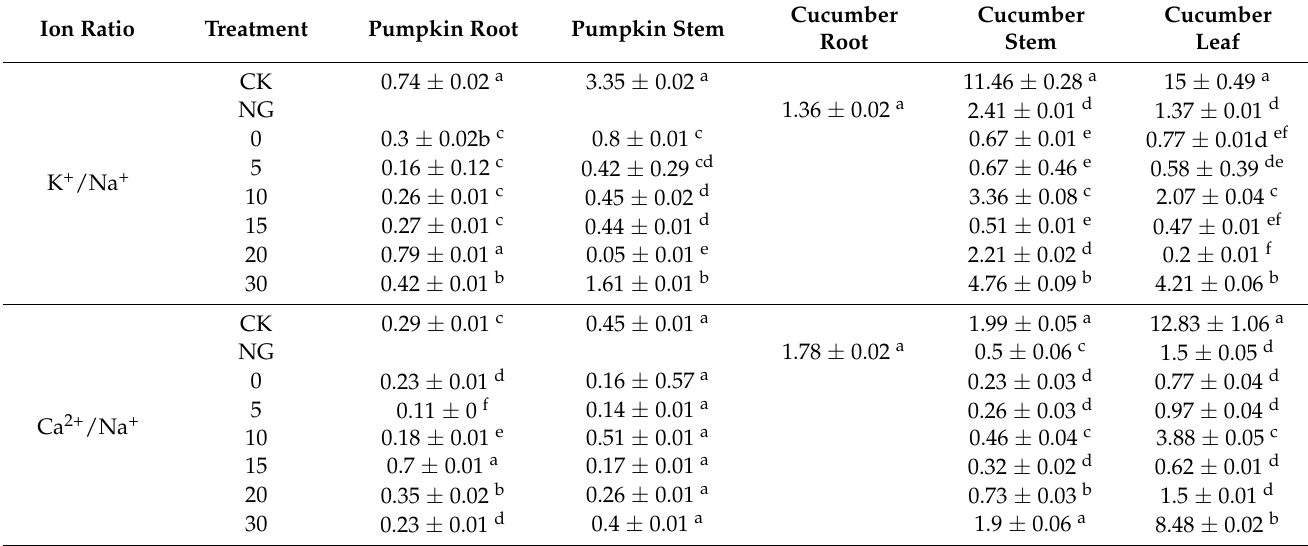
Table 2. Ratios of K + /Na + and Ca 2+ /Na + in different parts of grafted plants and no-graft plants under salt stress. The same letter in the same parameter and column denotes no significant difference ( p < 0.05) by the least significant difference (LSD) test. Values are means ± standard error (SE) ( n =